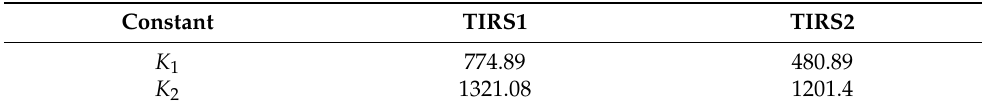
Table 3. Preset constant values of TIRS dataset in Landsat-8 satellite. Constant TIRS1